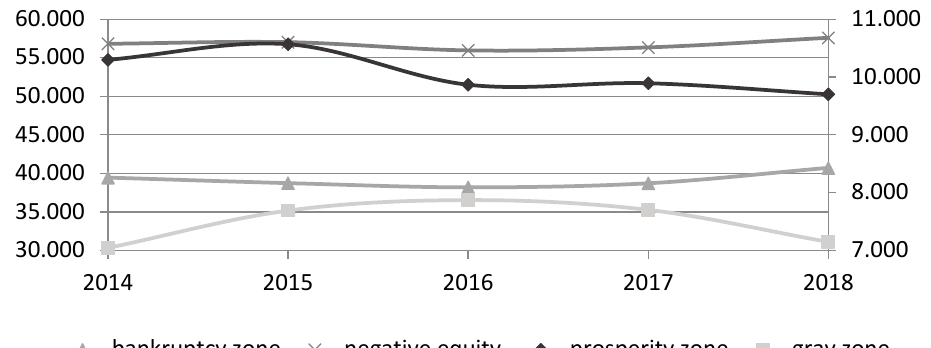
Figure 7. The relationship between a negative equity and a performance examined according to Altman's Z-score.